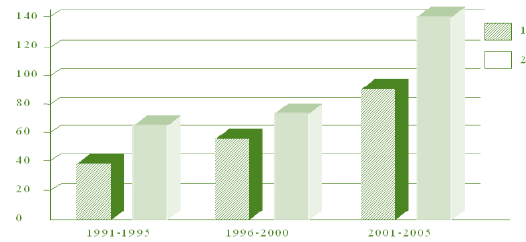
Fig.1. Tendency in EPS blackouts problem: 1 – The number of outages affecting more than 50000 consumers; 2 – The number of outages greater than 100 MW